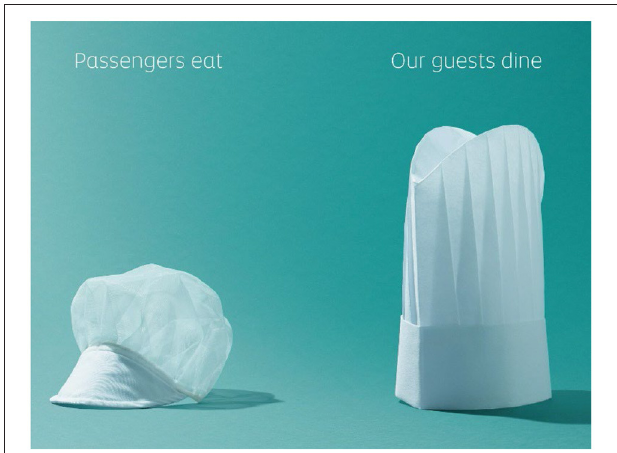
FIGURE 4 | Extract from an airline advertisement (airline